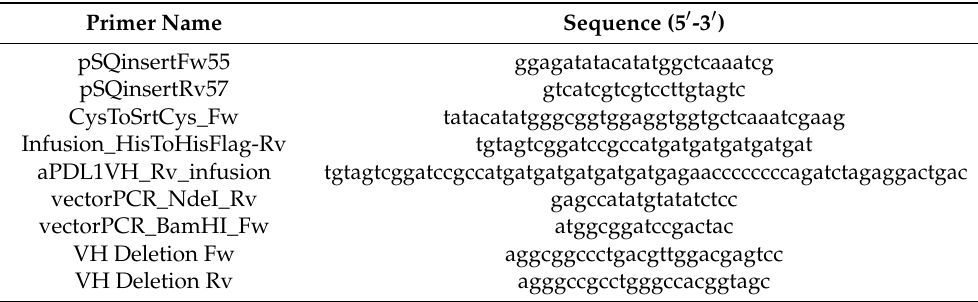
Table 1. Nucleotide sequences of primers used in this study.